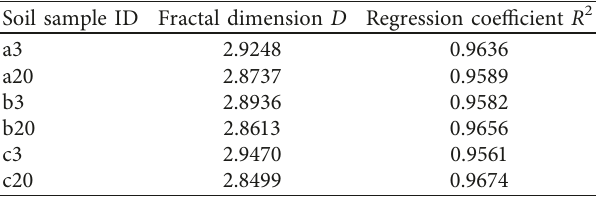
Figure 7: The log dV dP log P regression curves of the remounted soil samples. (a) a3; (b) b3; (c) c3; (d) a20; (e) b20; (f) c20. m / ( ) − Table 6: Calculated fractal dimensions and regression coefficients of different soil samples.